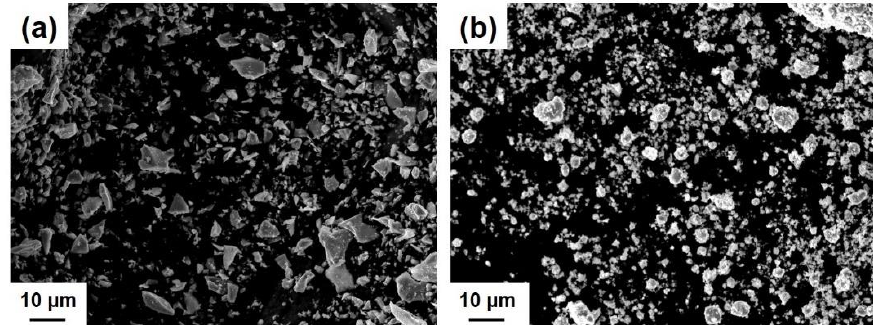
Figure 6. SEM views of particles of powder A ( a ) and B ( b ).